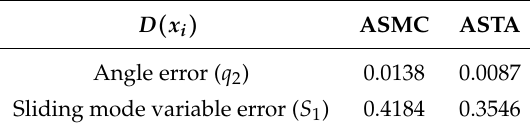
Table 3. Root mean square (RMS) errors in Case 1.